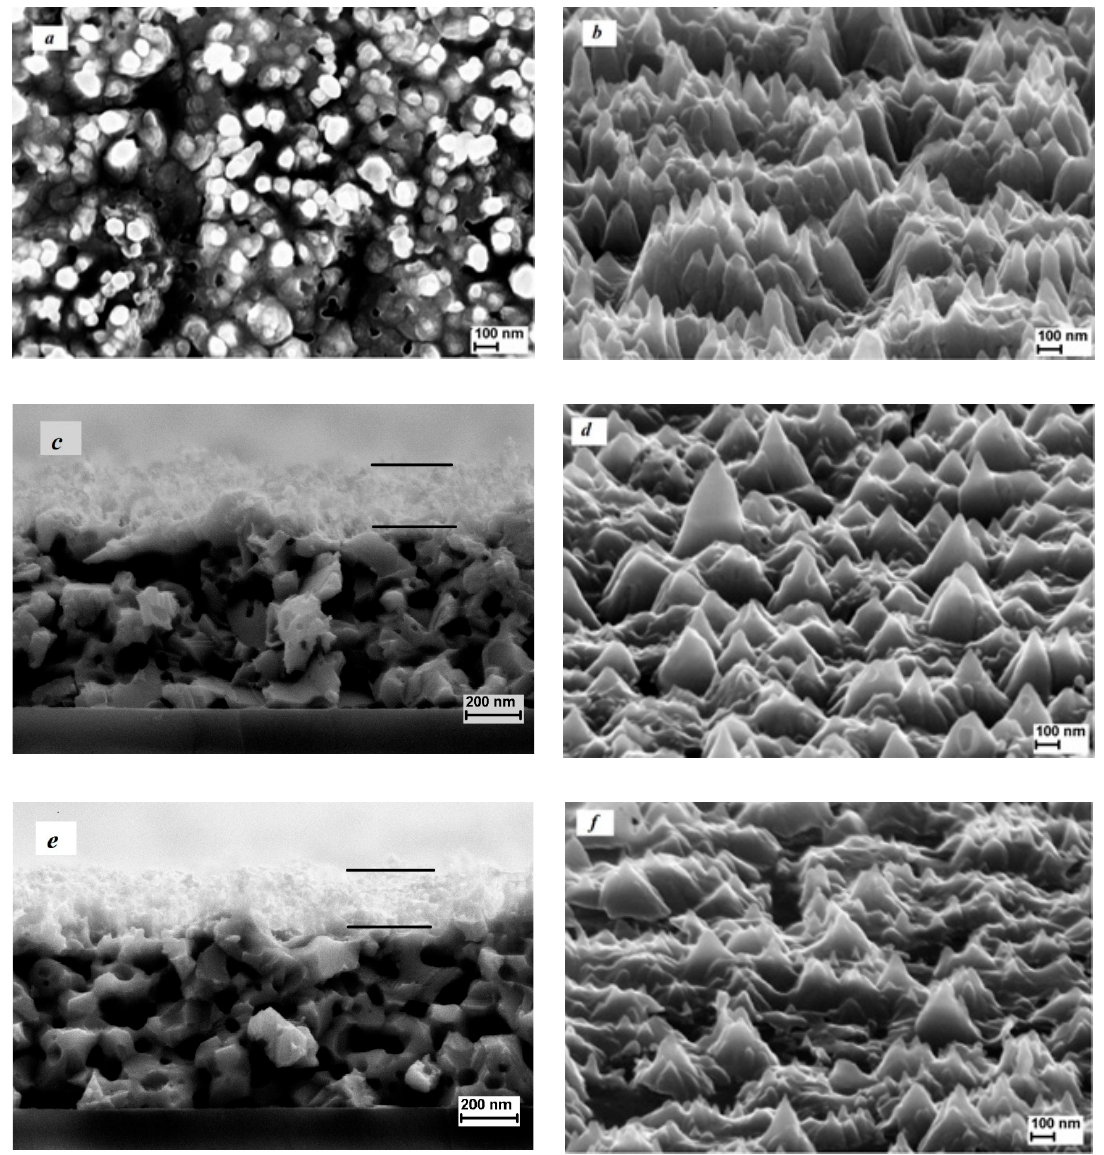
Figure 3. SEM images of the copper selenide film surface after plasma treatment at ion energy of 25 eV and durations of 30 s ( a , b ), 60 s ( c , d ), and 90 s ( e , f ). The sample tilts during imaging were 0° ( a ) and 70° ( b , d , f ). ( c , e ) Cross-sections of film, where the black lines are the borders of the lower and upper layers.